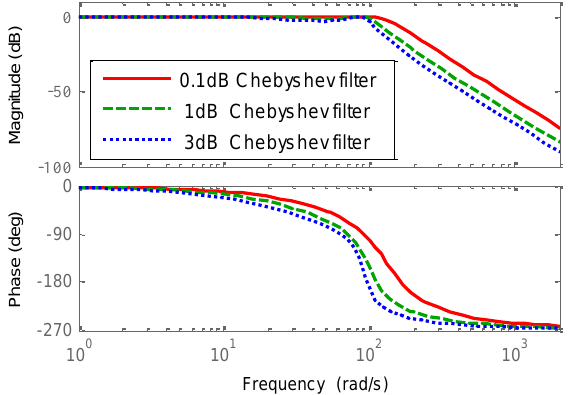
Figure 5. Bode diagram of the third-order Chebyshev filter with different ζ .